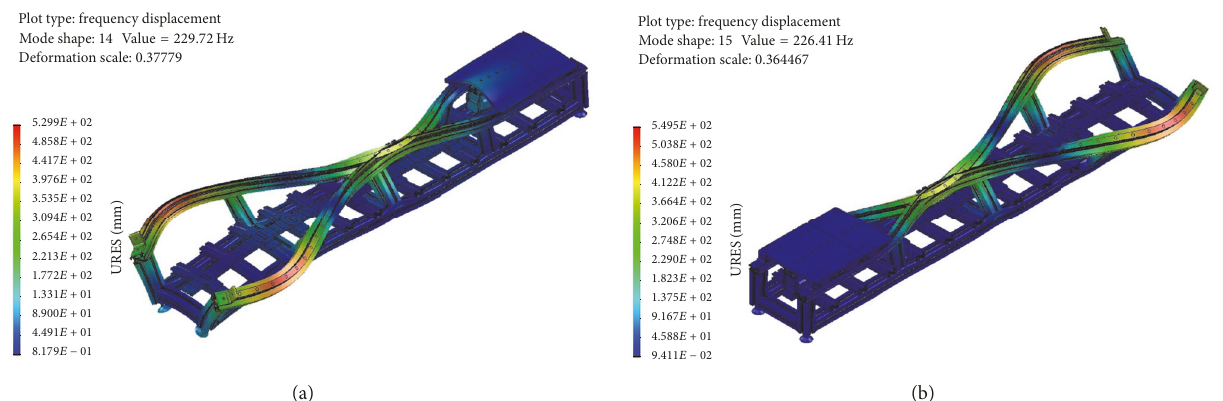
Figure 14: Second-order mode shapes (mode 15), with transversal displacement on top lateral bars: (a) position P1 ( 𝑓 ≈ 230 Hz, def. scale ≈ 0.377); (b) position P5 ( 𝑓 ≈ 226 Hz, def. scale ≈